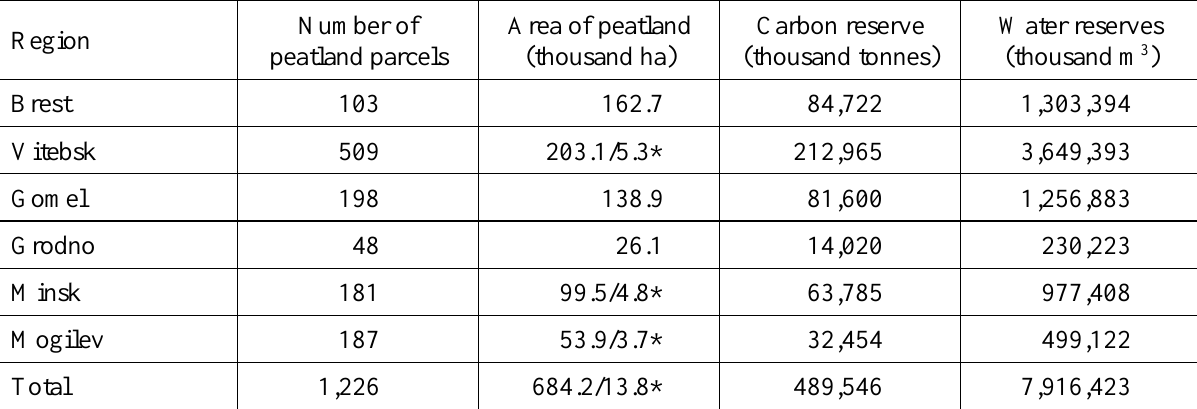
Table A2.2. Breakdown per region of (peat)land parcels (whole peatlands or portions of peatlands) which are subject to strict and/or special